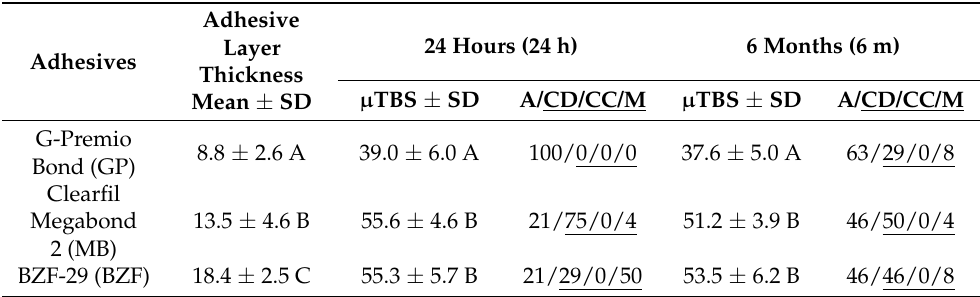
Table 2. The mean values ± standard deviations (SD) of adhesive layer thickness (in µ m) and µ TBS (in MPa; n = 8), and the percentage of fracture modes (A/CD/CC/M) *.